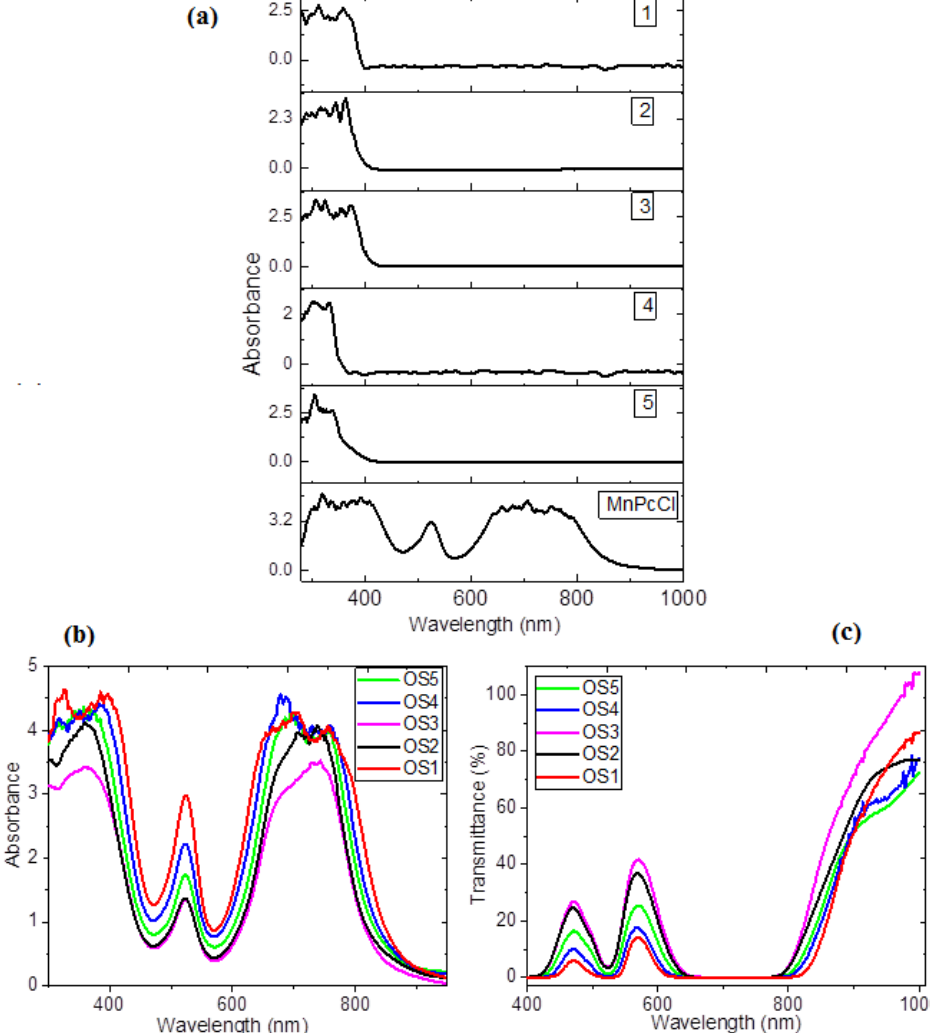
Figure 4. ( a ) Absorbance of MnPcCl and chalcones 1–5. ( b ) Absorbance and ( c ) transmittance optical spectra of MnPcCl–chalcone films.